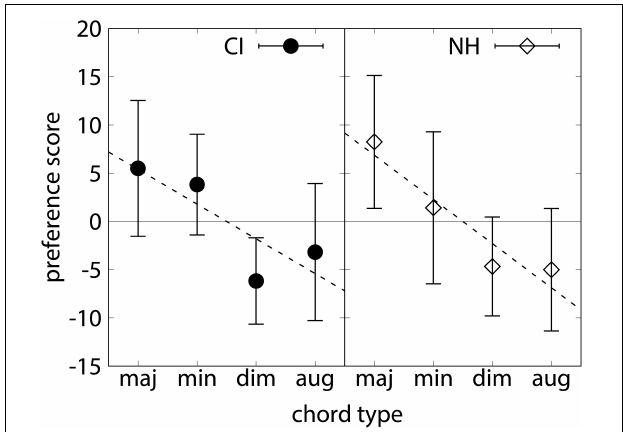
FIGURE 3 | Mean preference scores of the different chord types in experiment 2 (chord preference task), CI listeners (left panel) and NH listeners (right panel). Error bars indicate standard deviation.